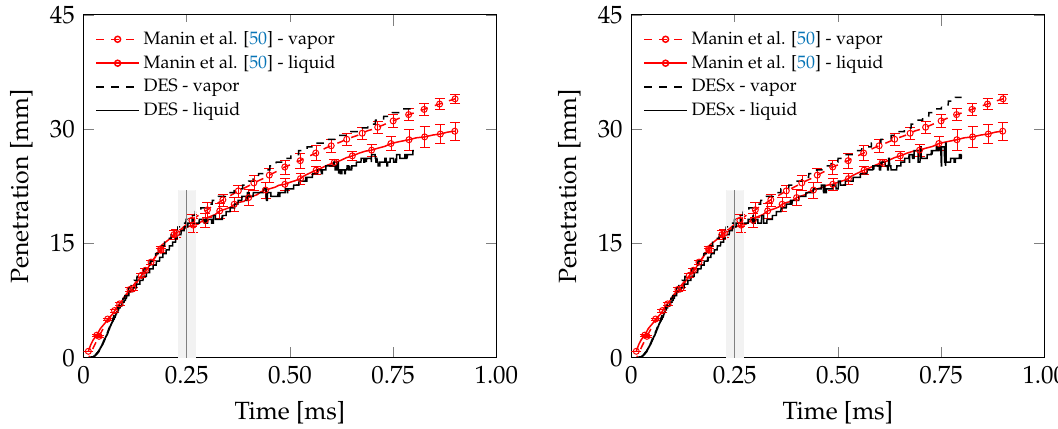
Figure 6. Liquid and vapor penetrations as predicted by DES ( left ) and DESx ( right ) simulation on the fine mesh (minimum grid size equal to 0.125 mm) in comparison with experimental data of SNL reported in Manin et al. [50]. The gray band corresponds to the time interval in which the separation between vapor and liquid phases occurs, as predicted by the numerical